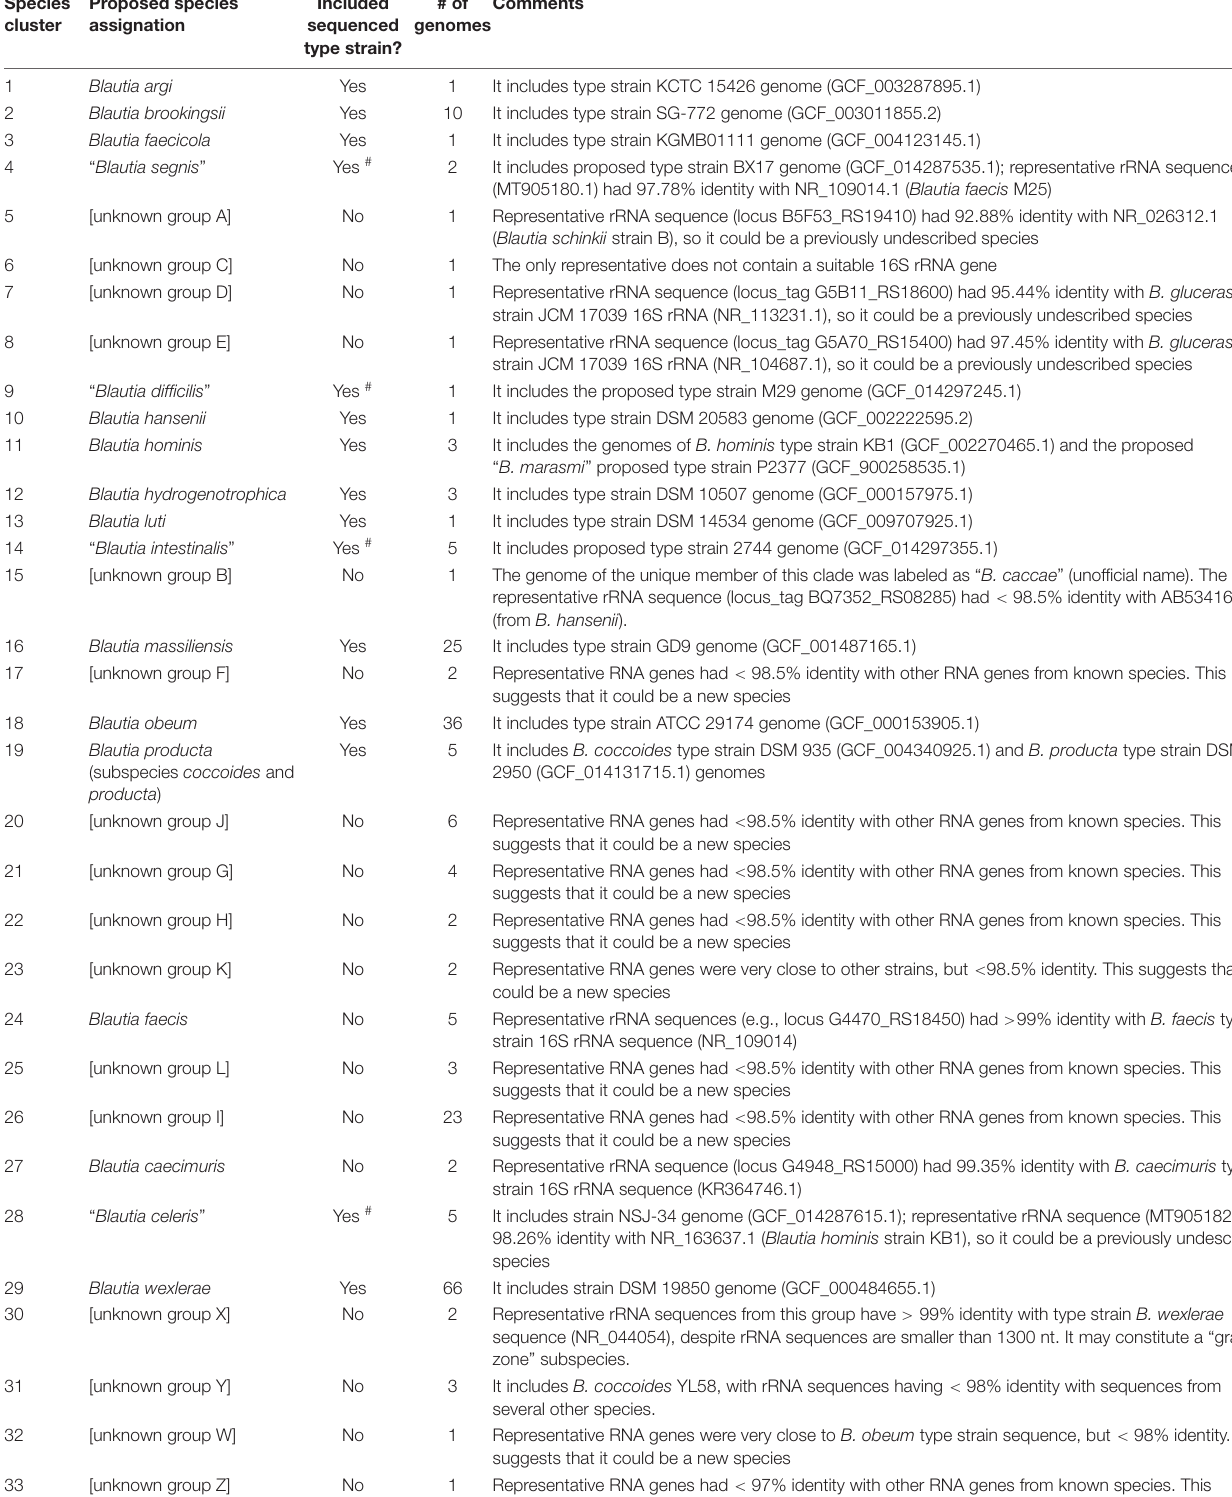
TABLE 1 | Genomic species groups found in the Blautia dataset from the use of ANI, TETRA and AAI data. Species